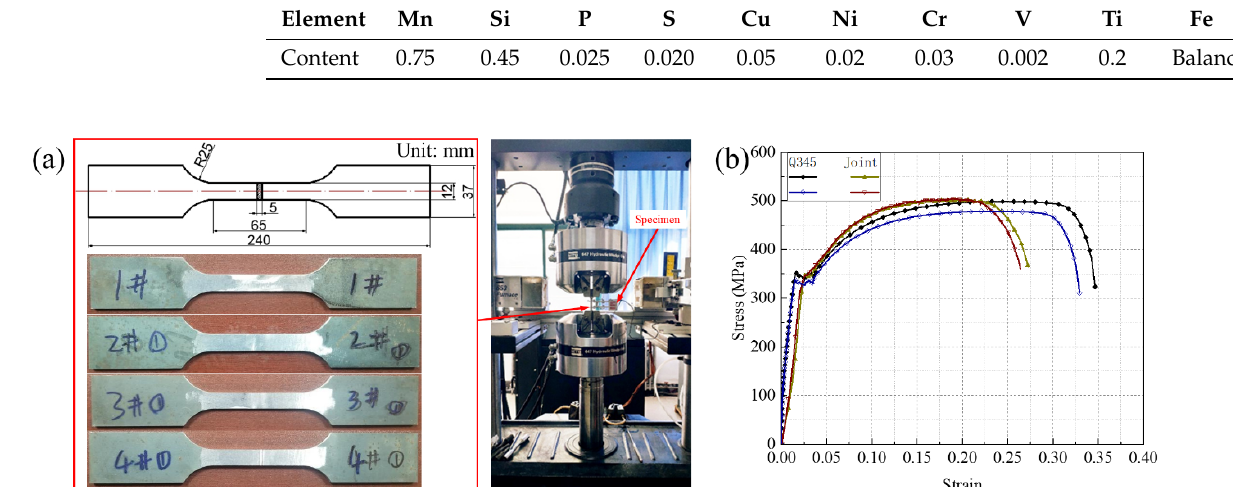
Figure 2. Detailed experimental setup ( a ) and stress-strain curves ( b ) for base material and butt joint.